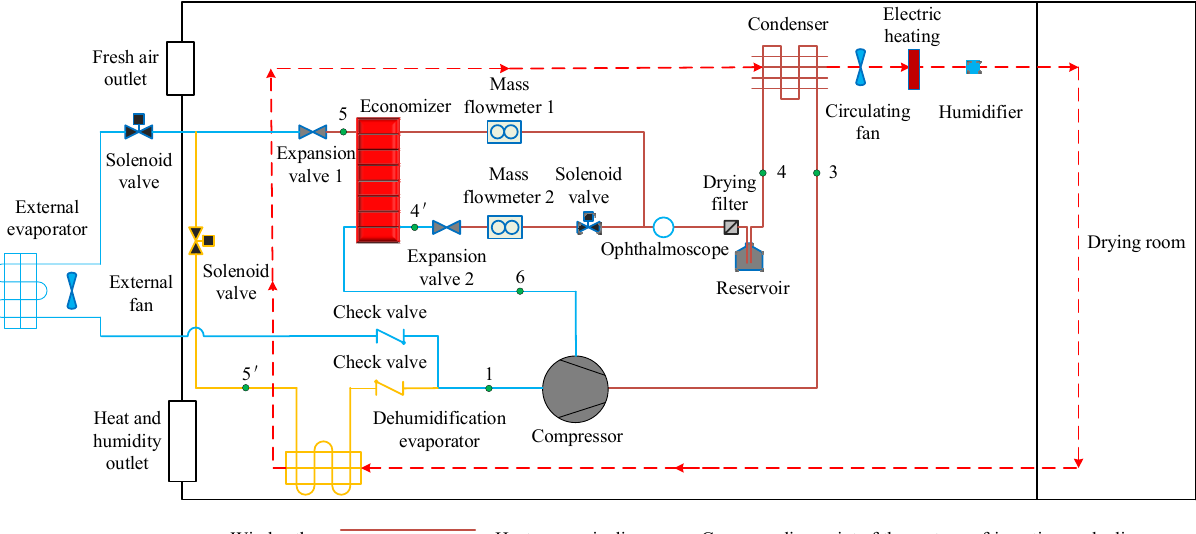
Figure 1. Schematic diagram of the heat-pump drying system with double evaporator.